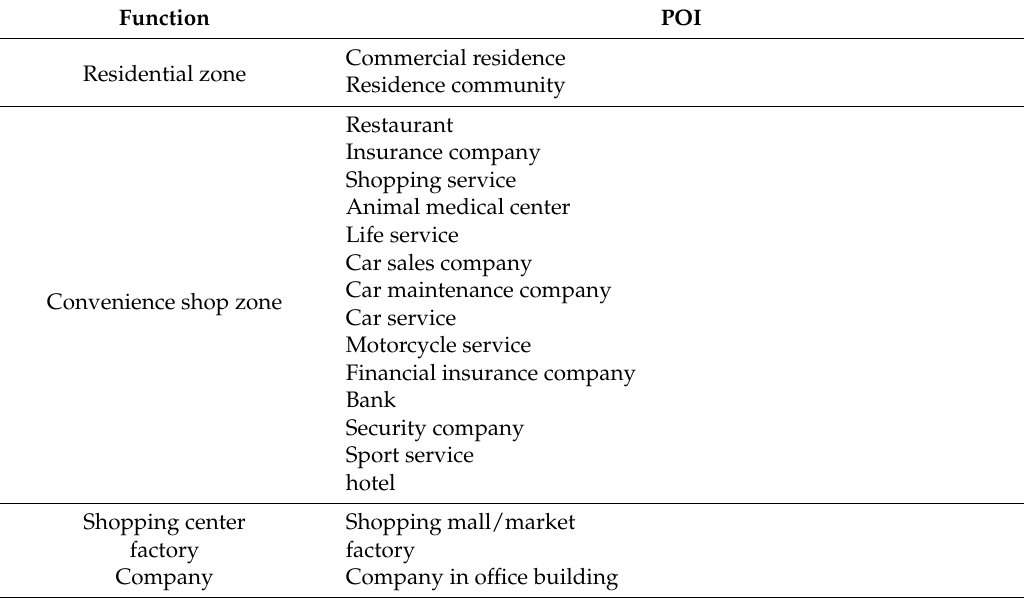
Table A1. The classification of points of interests